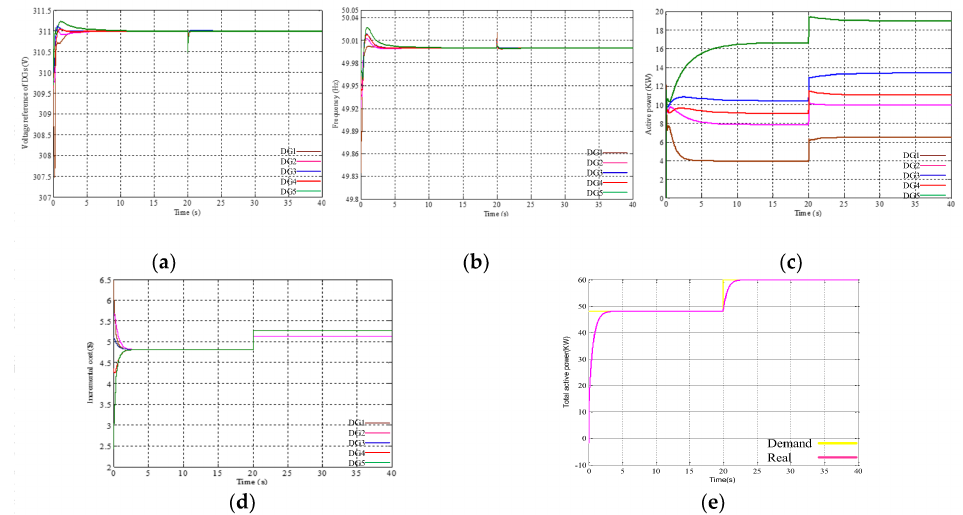
Figure 6. Simulation results with load changing. ( a ) Voltage reference of DGs. ( b ) Frequency of DGs. ( c ) Active power of DGs. ( d ) Incremental cost λ . ( e ) Total active